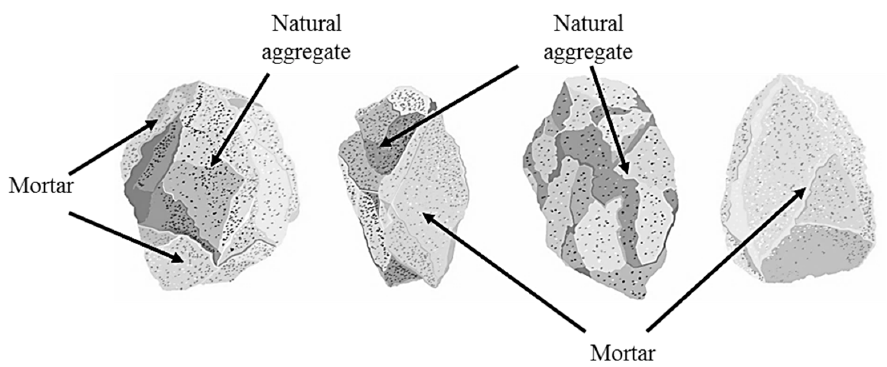
Figure 1. Typical conformations of the recycled concrete aggregate (RCA).